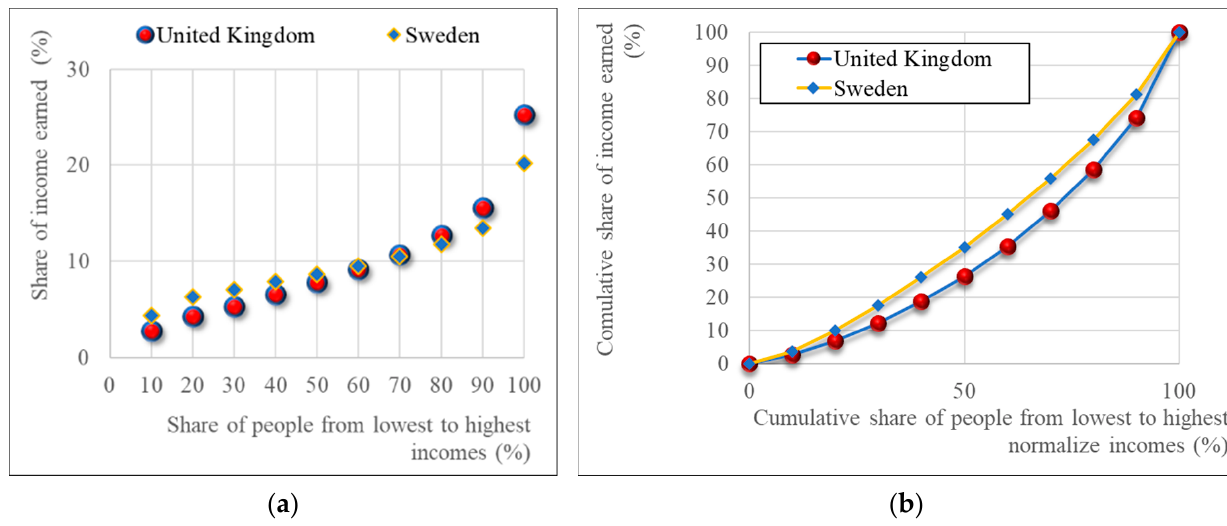
Figure 13. 1991 Share of income in Sweden and the United Kingdom; ( a ) tenths of the share (%) of people from the lowest to highest income versus share (%) of income earned ( b ) Lorenz curve.